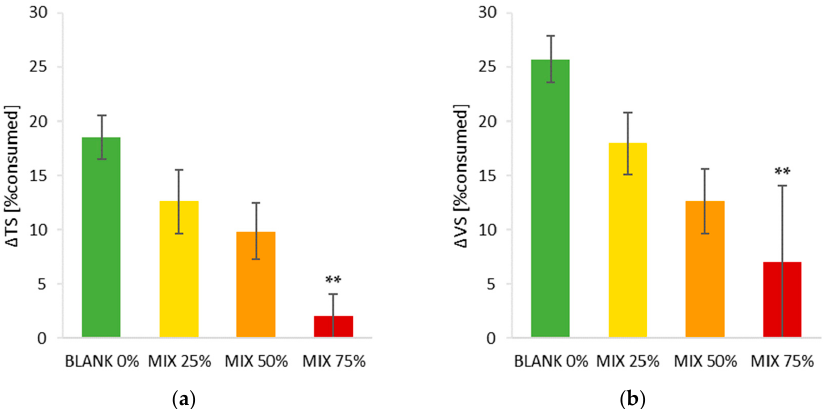
Figure 7. Percentage consumption of: ( a ) total solids (TS) and ( b ) volatile solids (VS) on dry basis of the biomass due to composting process. ** No statistically significant difference.